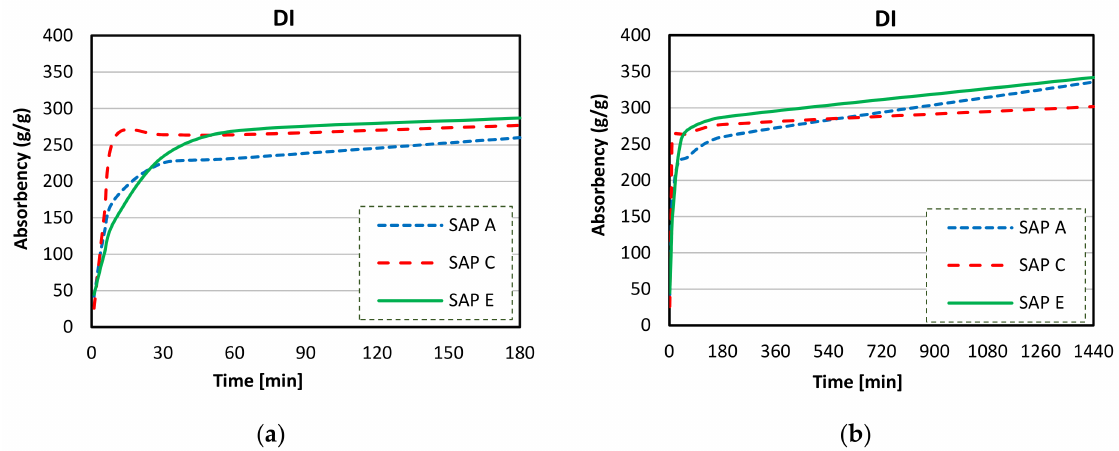
Figure 12. Sorption behaviour of SAPs in DI water up to 180 min ( a ) and up to 1440 min ( b